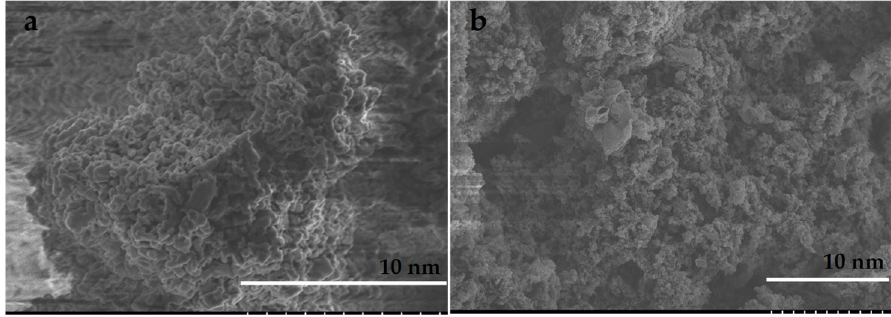
Figure 2. SEM images for ( a ) arsenate-imprinted membrane, ( b ) ammonia-imprinted membrane.